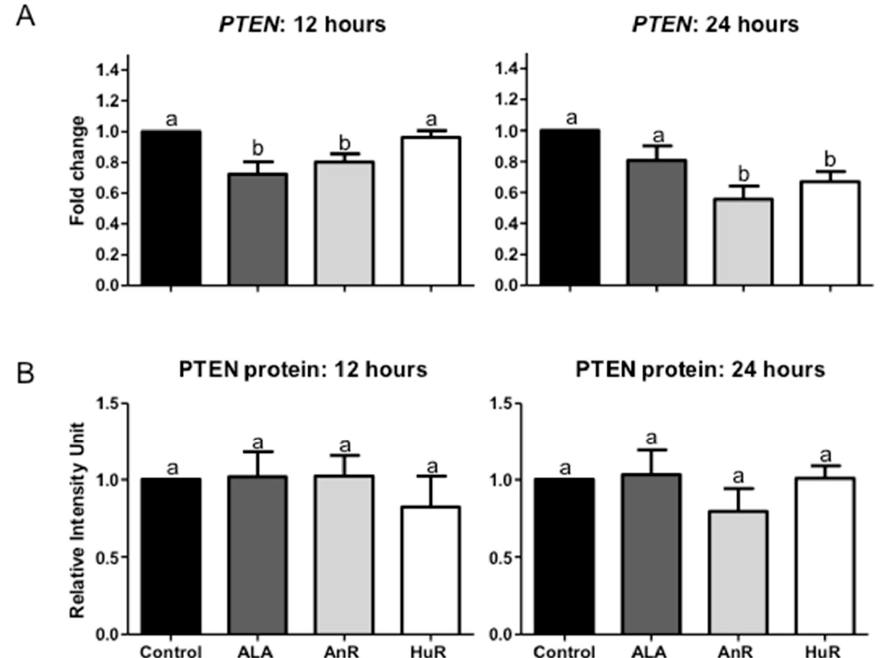
Figure 3. ( A ) Effect of ALA alone and combined with EPA and DHA on PTEN gene expression.